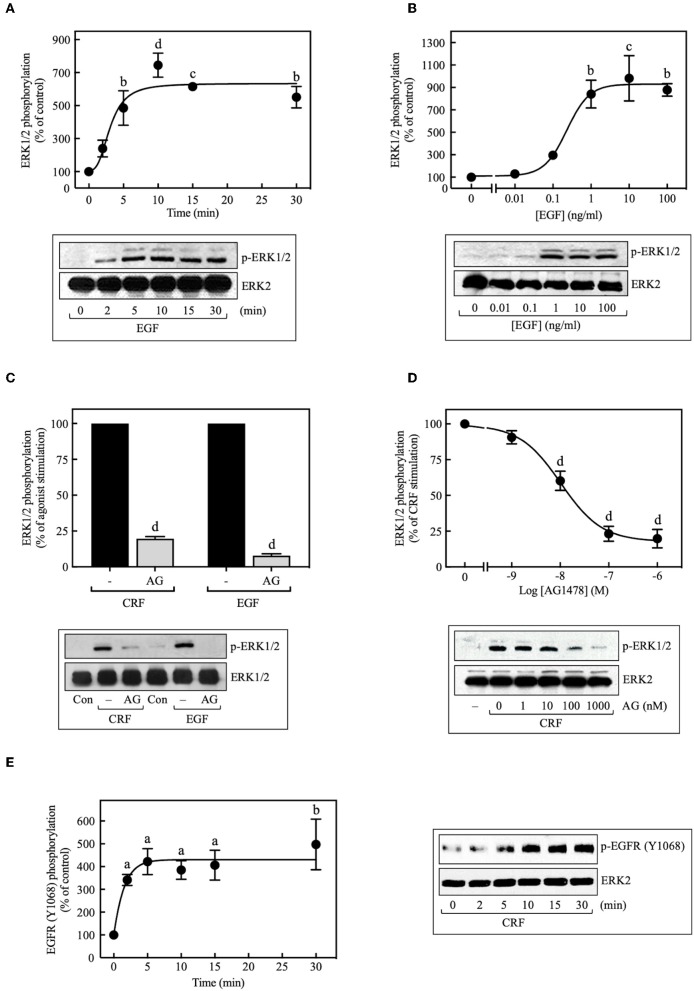
Involvement of EGFR transactivation in CRF-stimulated ERK1/2 phosphorylation. COS-7 cells expressing HA-CRF1Rs were treated with 10 ng/ml EGF for the indicated times (A) or exposed to the indicated concentration (B) of EGF for 10 min. COS-7 cells expressing HA-CRF1Rs were pretreated with 100 nM (C) or the indicated concentrations of AG1478 (AG) (D) for 30 min, before stimulation with 100 nM CRF for 5 min (C,D) or 10 ng/ml EGF for 10 min (C). (E) Effect of 100 nM CRF on EGFR phosphorylation at Tyr1068. Total cell lysates were separated by SDS-PAGE and analyzed by immunoblotting with anti-p-ERK1/2 Thr202/Tyr204
(A–D) or anti-p-EGFR Tyr1068
(E), as described in Materials and Methods. ERK1/2 and EGFR phosphorylation were quantitated by densitometry, and mean values were plotted from three to five independent experiments. Vertical lines represent the S.E.M. Western blots were also probed for total ERK, showing equal loading. (A)
bp < 0.01, cp < 0.001, dp < 0.0001 vs. 0 min. (B)
bp < 0.01, cp < 0.001 vs. 0 ng/ml. (C)
dp < 0.0001 vs. CRF (–); dp < 0.0001 vs. EGF (–). (D)
dp < 0.0001 vs. 0 M. (E)
ap < 0.05, bp < 0.01 vs. 0 min.